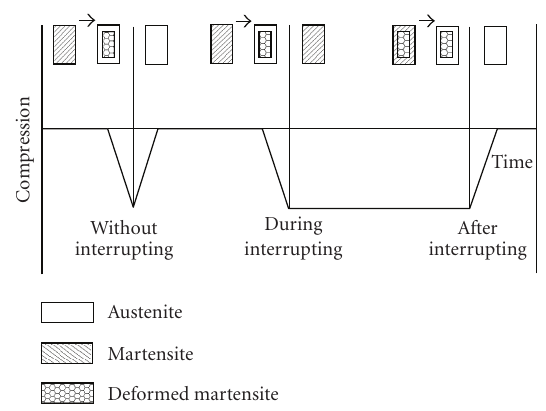
Figure 7: Scheme of evolution of the thermoelastic deformations in the sample during the phase